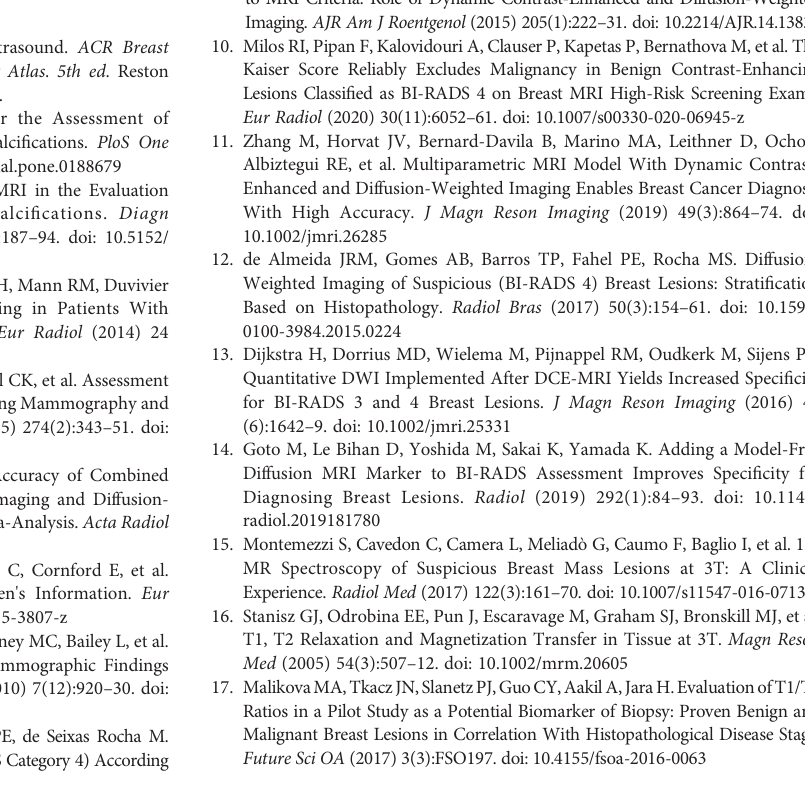
Supplementary Figure 1 | The imaging protocol of MRI scanning. Supplementary Figure 2 | The fl owchart of patient enrollment. Supplementary Figure 3 | Nomogram for prediction of breast